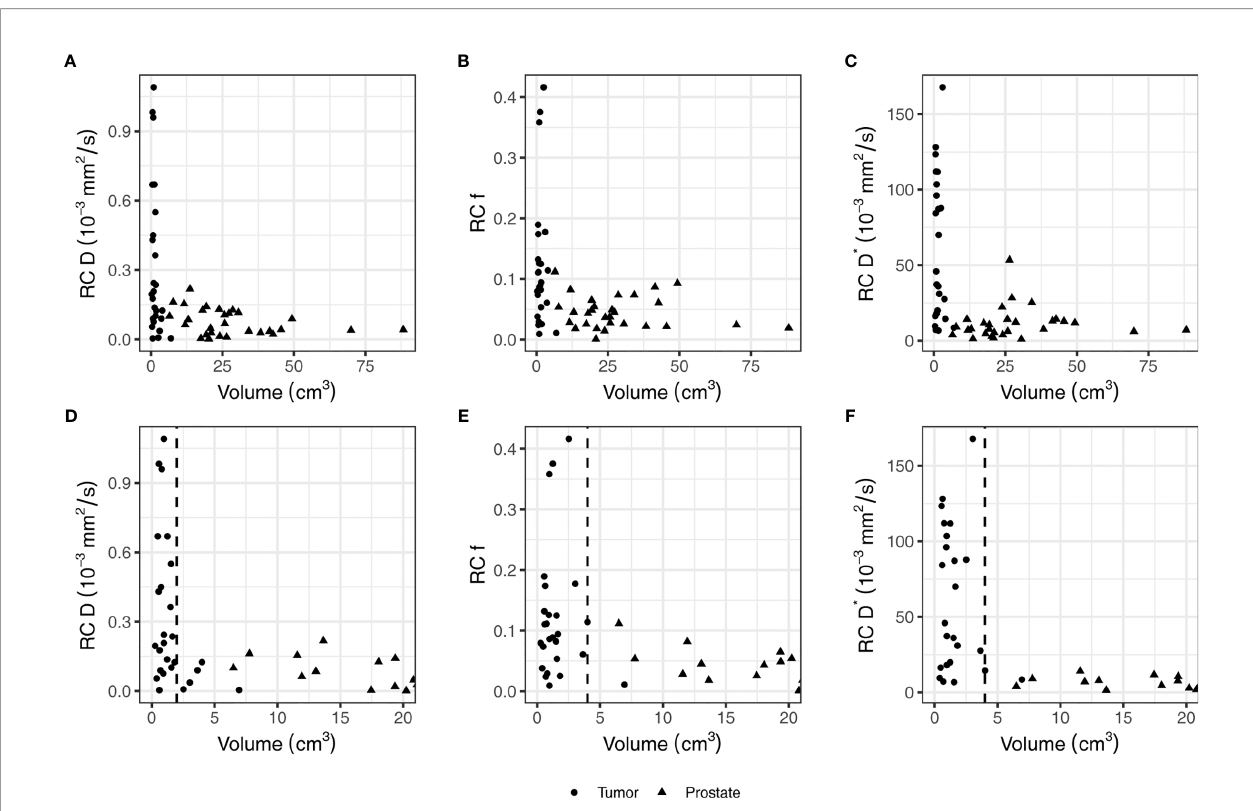
FIGURE 2 | The repeatability coef fi cients (RCs) of individual patients for the IVIM parameters based on the values from the tumor and non-cancerous prostate on the fi rst and second treatment fraction. Figures (A – C) show all data points while fi gures (D – F) show the same data but zommed in on the smaller volumes. In fi gures (D – F) , a vertical dashed line indicates the volume below which the RC steeply increases. This value is 2 cm 3 in (D) and 4 cm 3 in (E, F)